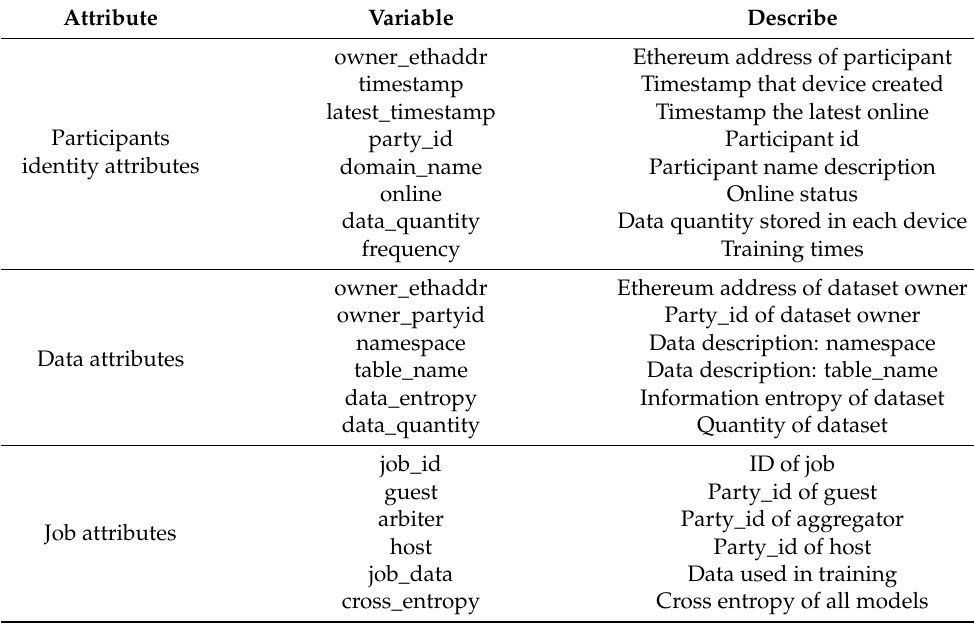
Table 3. Attributes of information